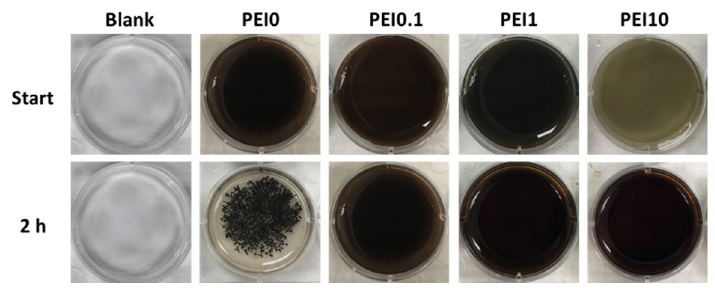
Figure 1. Photographs of the color of the reaction solution.